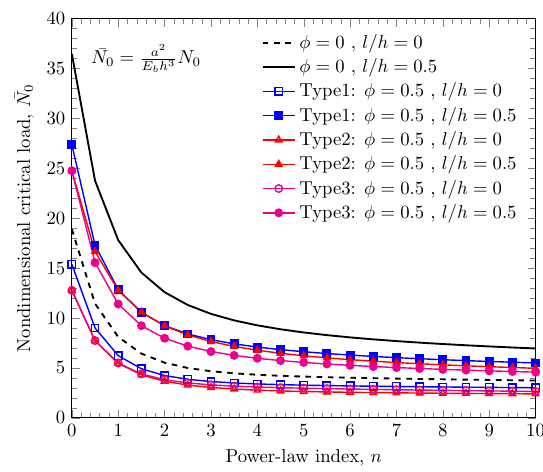
Figure 10. Non-dimensional critical buckling load, ¯ N 0 versus power-law index, n